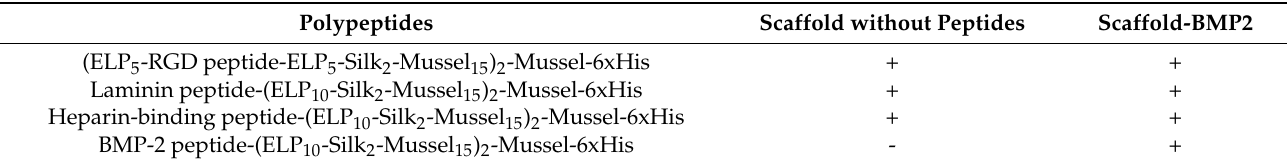
surface micromorphology of the scaffold without peptides, as no differences in morphology and porosity were observed between the two scaffolds. The BMP-2 peptide, which is only Table 2. Composition of crosslinked scaffolds.